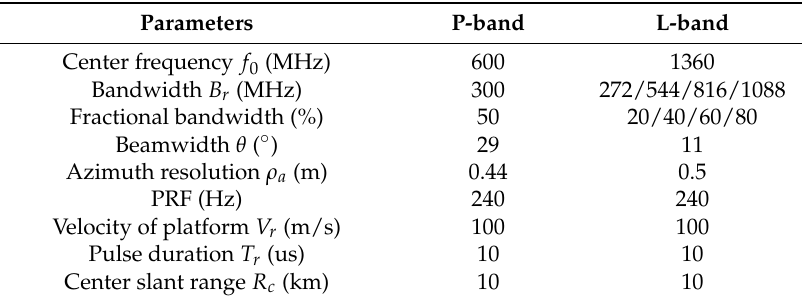
Table 1. SAR system simulation